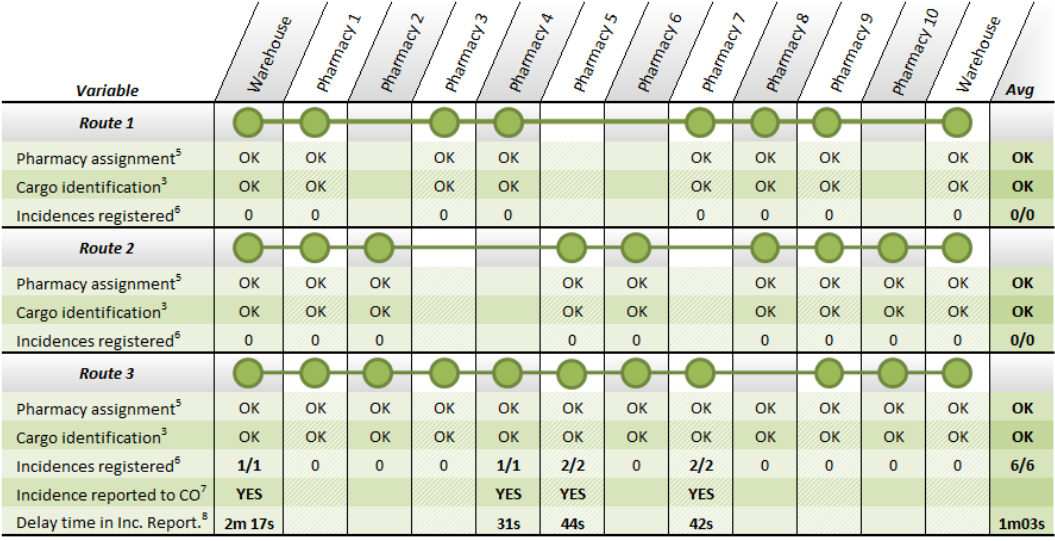
Figure 16. Results of the third phase of the system validation: the complete system. In the table, pharmacy assignment row indicates whether the stop is correctly associated to the corresponding stop; cargo identification row shows if the load carried at the stop is adjusted to the planning; and in incidences registered row, when the system detected an urgent incidence, the correct reception and the period from the reception until the reporting in the control center, are